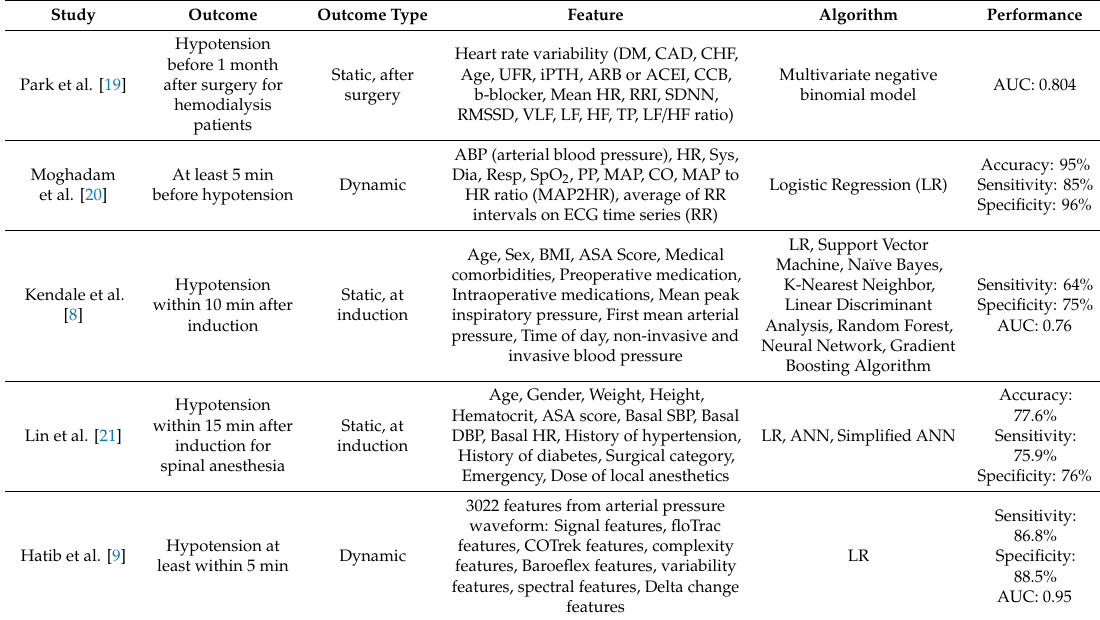
Table 1. The taxonomy of related studies on hypotension